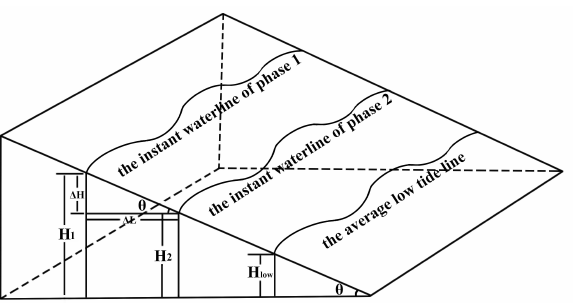
Figure 9. Schematic diagram of tidal correction. θ is the angle of the tidal flat slope. H 1 and H 2 represent the tide height at Time 1 and Time 2, respectively. ∆ H is the tidal height difference between different times, and ∆ L represents the average distance of the instantaneous waterlines of the two phases. H low is the average low tide